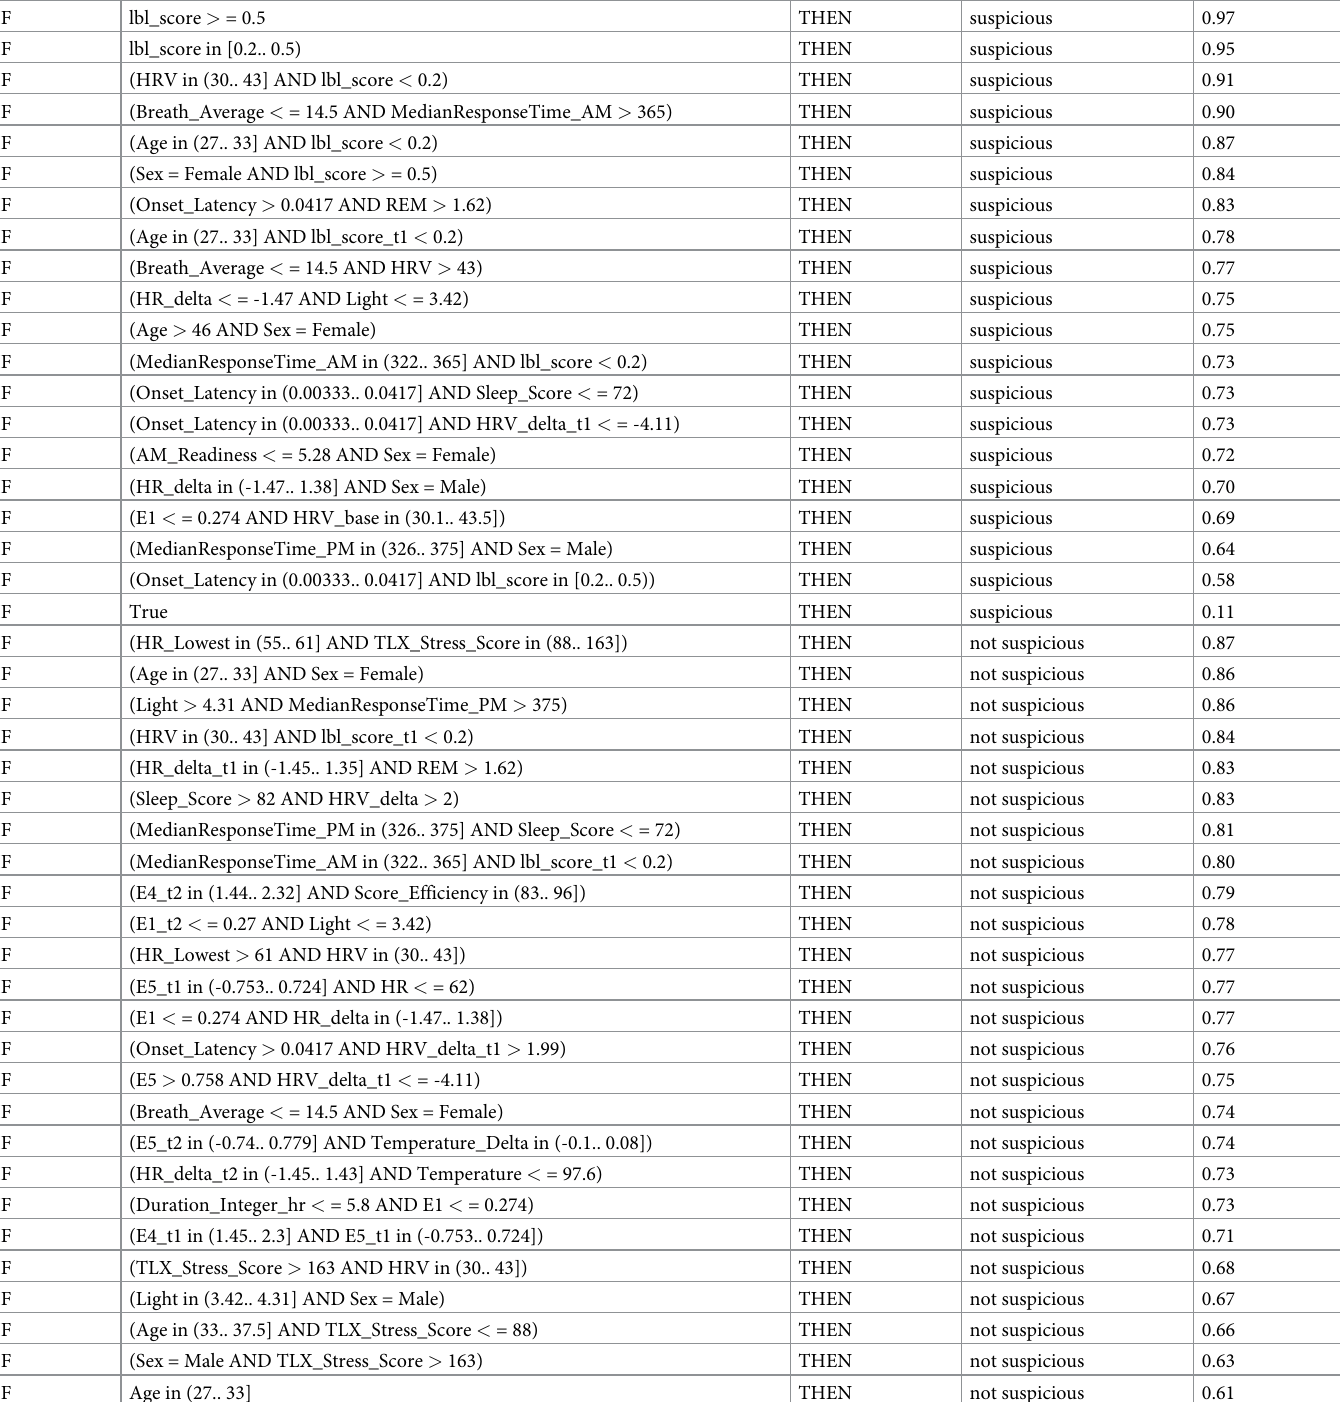
Table 3. Algorithm-derived rules list of 45 rules extracted by the algorithm and used in the model with their relative